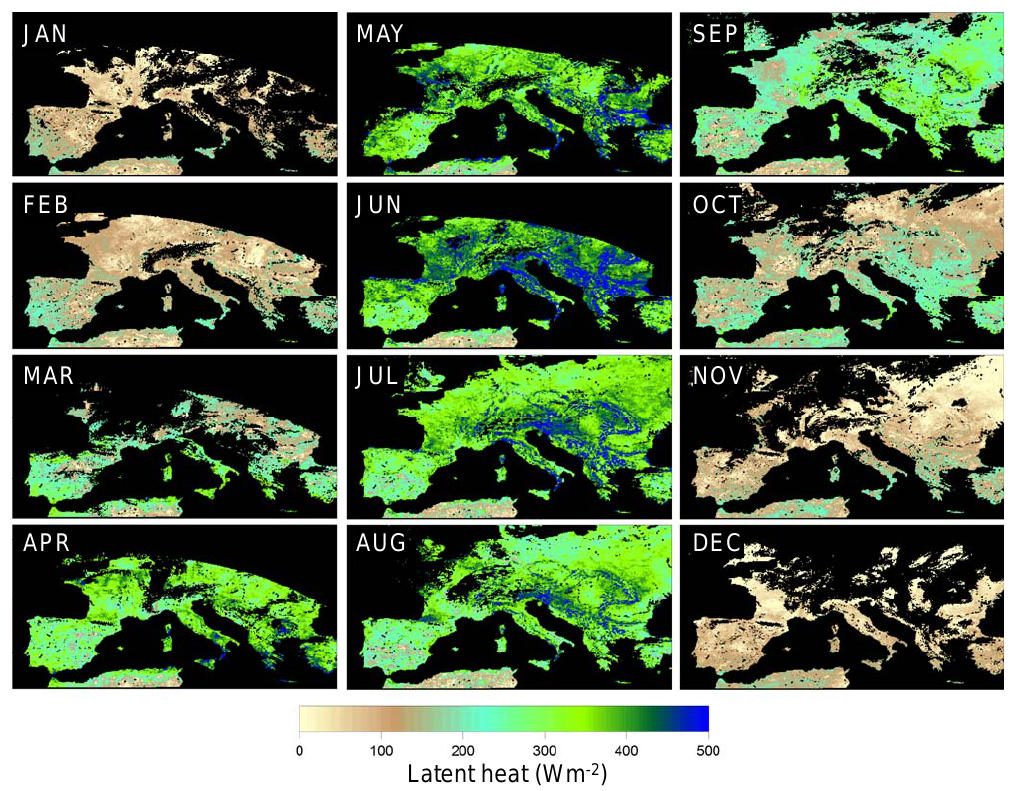
Fig. 7. Monthly composites of clear-sky latent heat flux (instantaneous, shortly before local noon) for 2008 over Europe, generated at 10-km resolution by ALEXI using MSG land-surface products. Snow-covered regions have not been simulated.